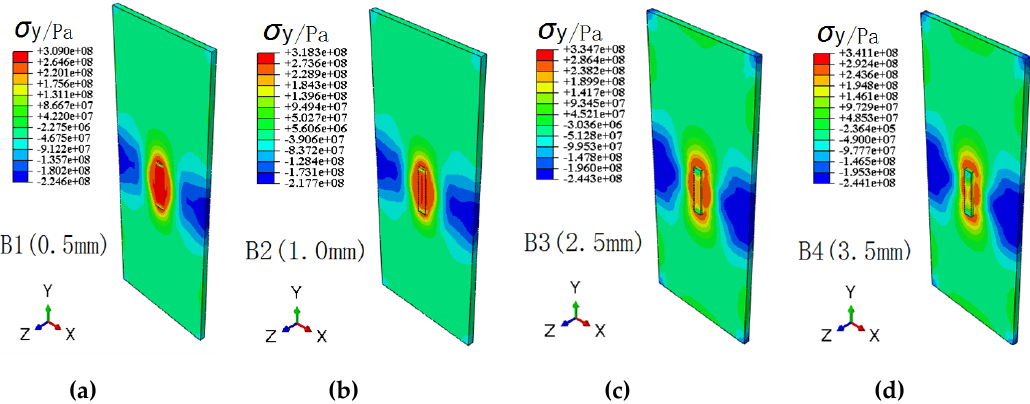
Figure 13. Contours of longitudinal residual stress for different repair weld reinforcement heights: ( a ) 0.5 mm, ( b ) 1.0 mm, ( c ) 2.5 mm and ( d ) 3.5 mm.